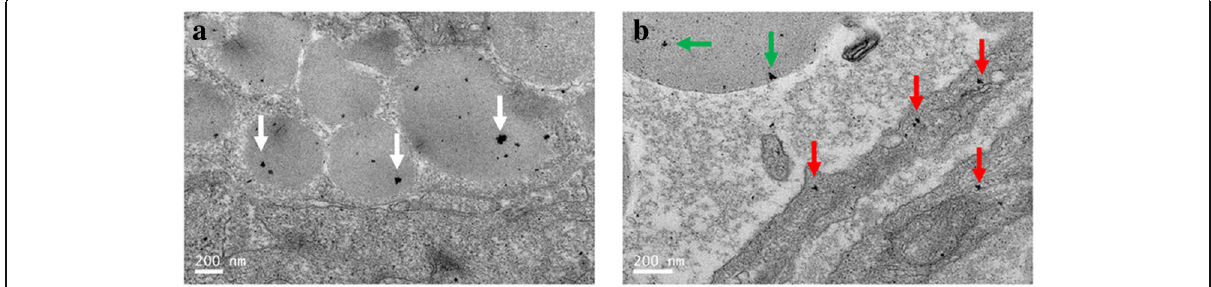
Fig. 5 Distribution of triangular silver nanoplates in the intestinal vessels of mice with CBD ligation. a Triangular silver nanoplates located in the blood corpuscle (white arrows). b Triangular silver nanoplates penetrated into the vascular wall (green arrows), while some located in the blood corpuscle (red